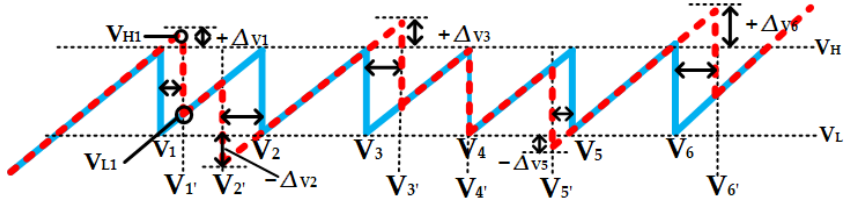
Figure 11. Automatic calibration of residual curves.